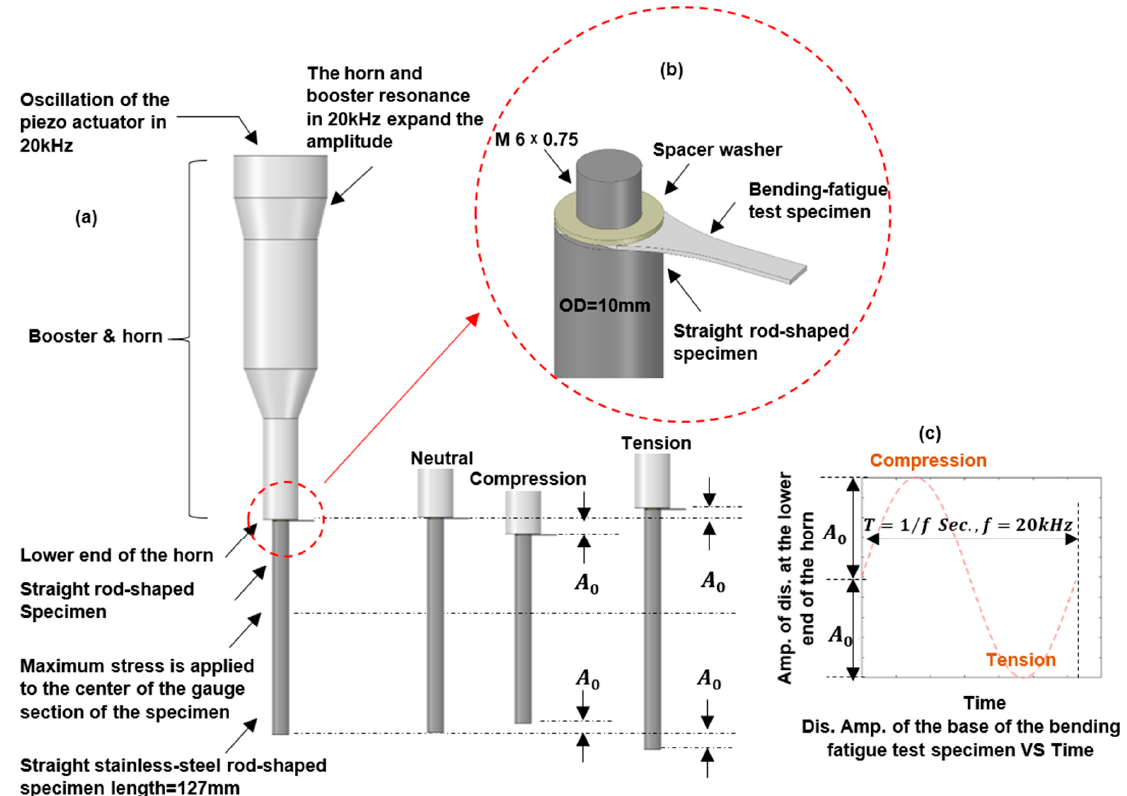
Figure 6. ( a , c ) The ultrasonic fatigue system operation principle and bending fatigue testing arrange- ment; ( b ) test arrangement